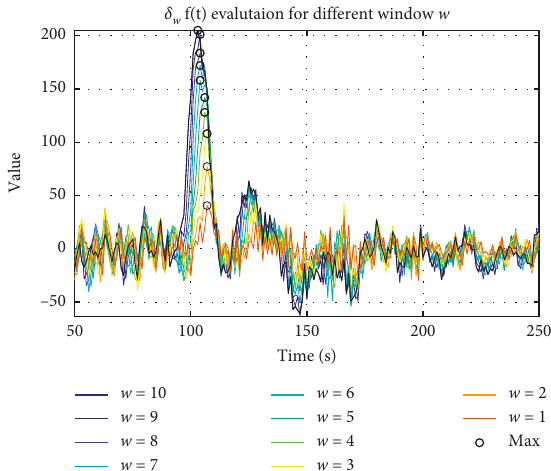
f t of PC1 for orders w w ( )